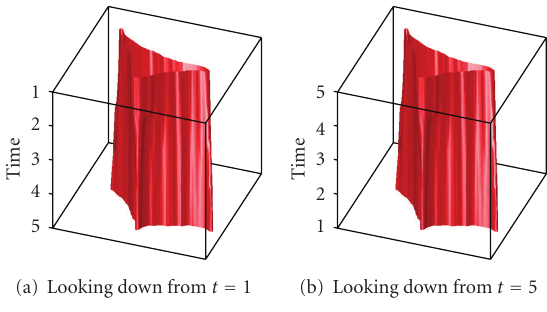
Figure 18: 3D representation of the